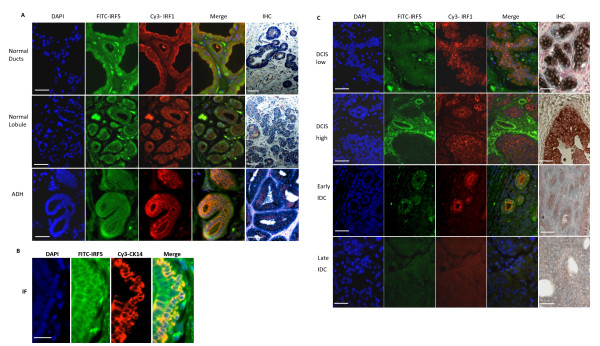
Dysregulated IRF expression in patients with ductal carcinoma. A. Normal and ADH breast tissue specimens were stained by IF or IHC. Antibodies recognizing IRF5 (FITC), IRF1 (Cy3) and DAPI for the nucleus were used for IF. For IHC, tissues were stained for IRF1 with DAB (brownish-red), IRF5 with BAP (blue), and nucleus with Fast Red mounting buffer. B. Same as in (A), except tissue samples from patients with ADH were stained by IF with IRF5 (FITC) and CK14 (Cy3) in order to confirm expression of IRF5 in myoepithelial cells. C. Same as in (A), except tissues from patients with DCIS and IDC were examined. Representative pictures of low grade and high grade DCIS are shown illustrating distinct differences between IRF1 and IRF5 expression. Images were taken on a Zeiss Axiovert Apotome microscope at 20 × or 40 × magnification. Scale bars are 50 μm.